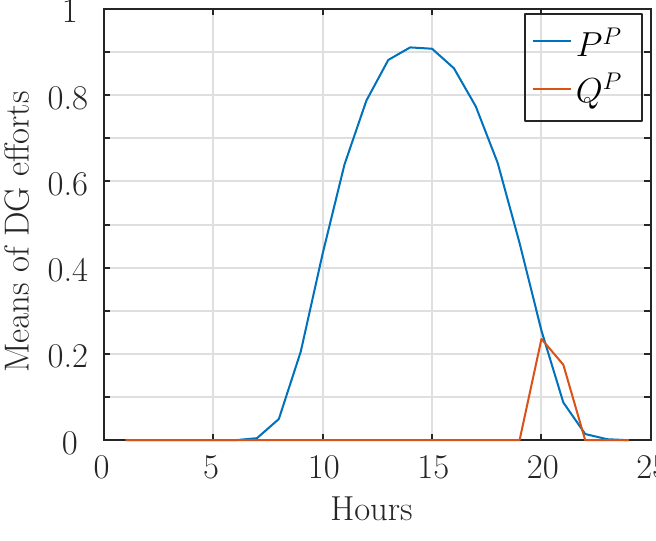
Figure 13. Means of DG